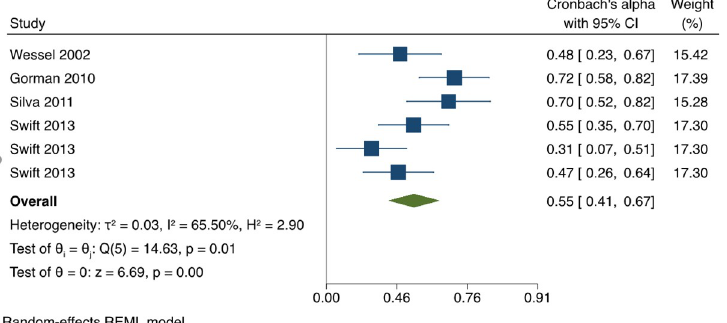
Fig 2. Meta-analysis of Cronbach’s alpha on OSCEs in physical therapy students. Forest plot presenting the meta- analyzed estimate on Cronbach’s alpha. Each square presents the results of an individual study with the size of the square being proportional to the weights used in the meta-analysis and the horizontal lines indicating the 95% confidence intervals. The solid vertical line represents no reliability, and the solid diamond indicates the overall summary measure.